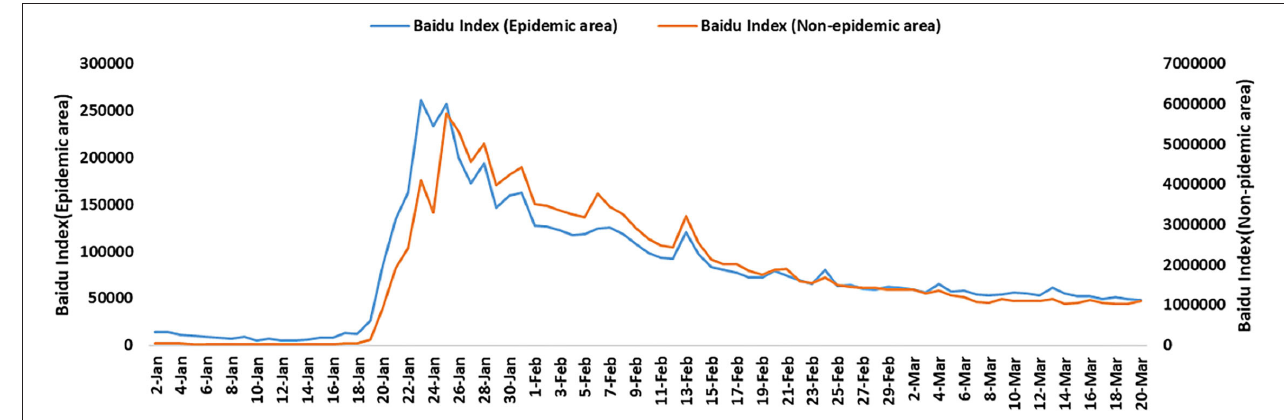
FIGURE 3 | The changing trend of the National Baidu Index and Hubei Baidu Index of COVID-19 in China from January 20 to March 20 in 2020.